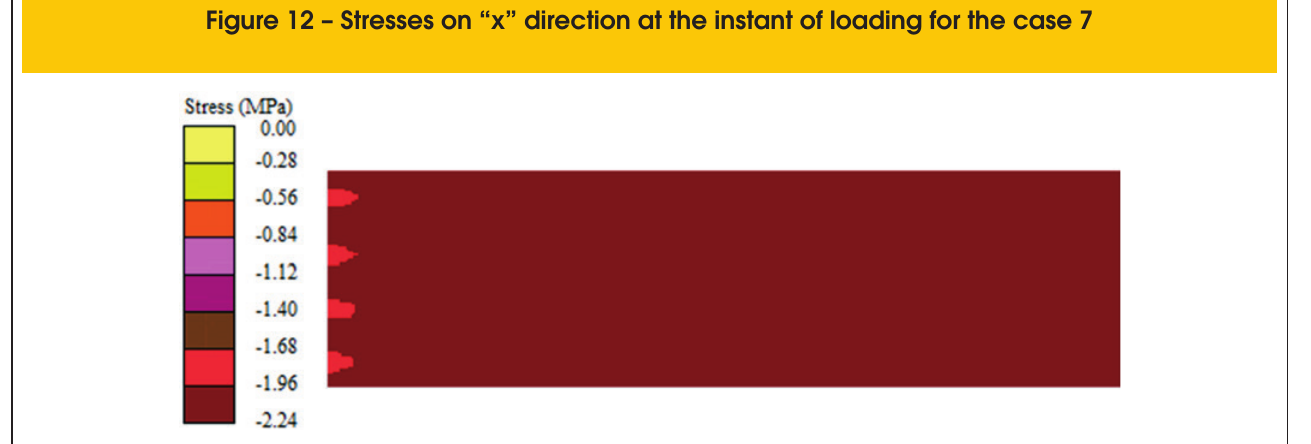
Figure 12 – Stresses on “x” direction at the instant of loading for the case